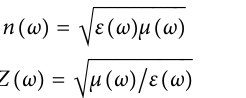
FIGURE 2 | Simulated absorbance of the proposed MPA, whose structure is shown in Figure 1 . The black solid line and the red solid line correspond to wavelengths of 1310 nm and 1550 nm, respectively. The corresponding peak at 1310 nm is labeled M, and the corresponding peak at 1550 nm is labeled